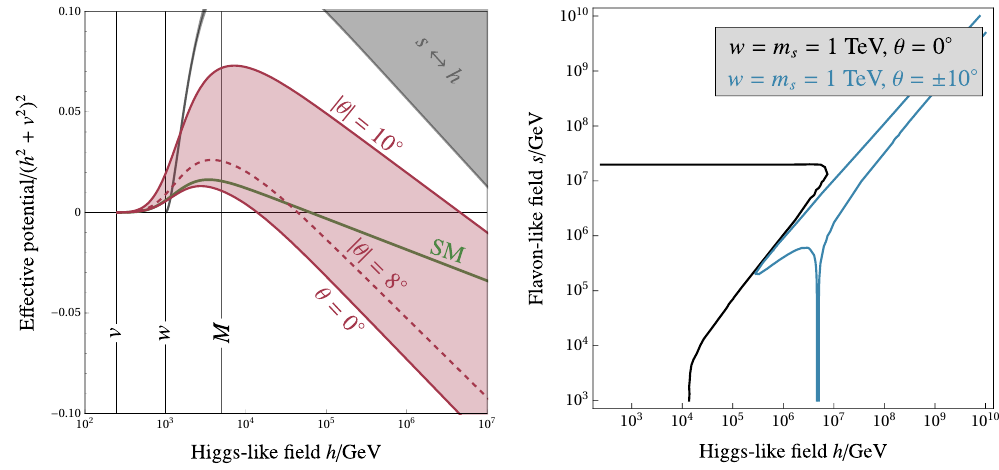
Figure 1 . The left panel shows the comparison between the e(cid:11)ective potential of the SM and the model invoking a Froggatt-Nielsen mechanism for the b quark in h -direction. The (cid:13)avon sector is (cid:12)xed as m (cid:27) = w = 1 TeV whereas the scalar mixing angle (cid:18) s varies (red band). The Froggatt- Nielsen scale is M = 5 TeV. The gray curve corresponds to the potential in s -direction. The right panel shows the zero-potential lines in the model with and without